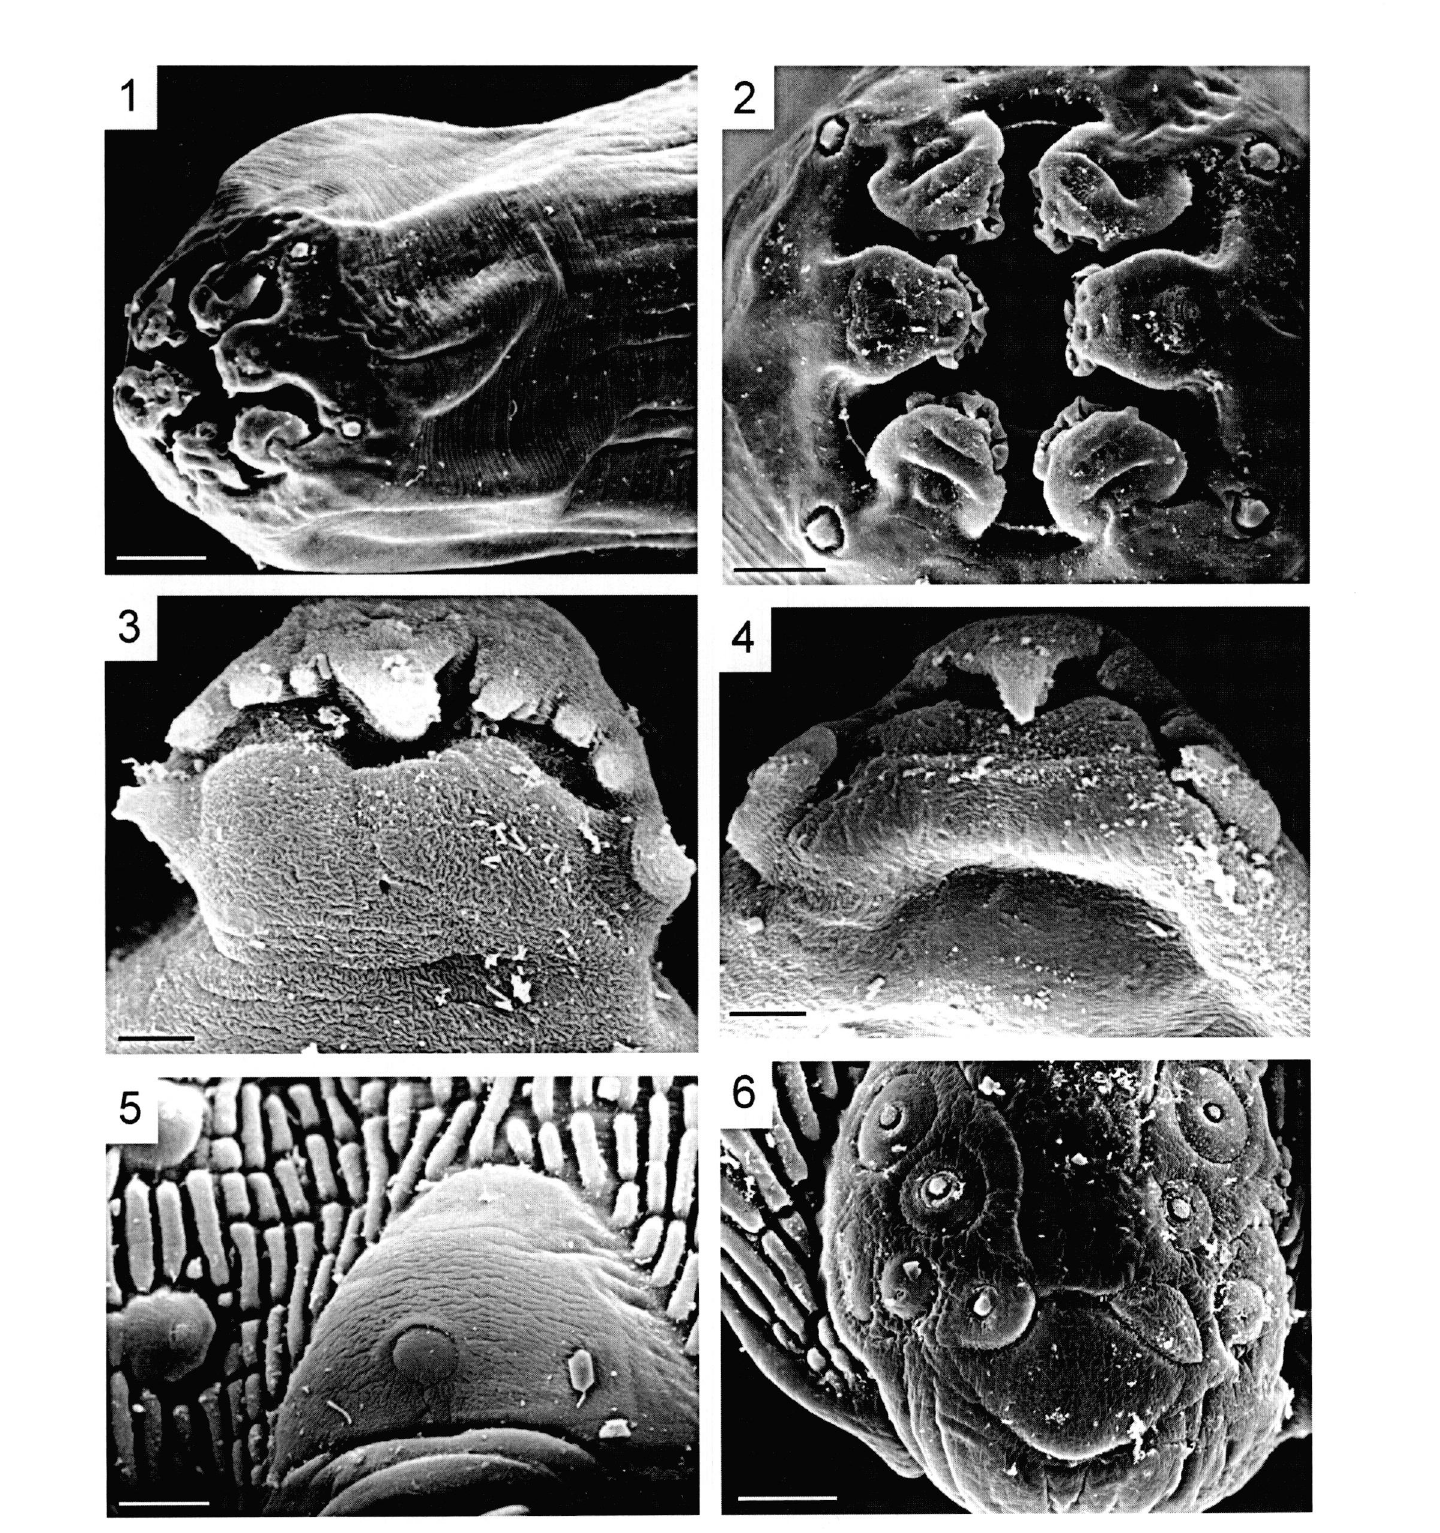
Figs 1-6. - Male of Mastophorus muris (Gmelin) from Graomys griseoflavus (Waterhouse). 1-2. anterior extremity: 1, lateral view; 2, apical view. 3-4, detail of pseudolabial teeth, showing symmetrical arrangement 1-3-1-3-1: 3, lateral lobe; 4, submedian lobe. 5-6, detail of caudal papillae, ventral view: 5, unpaired precloacal papilla; 6, distal sessile papillae. Scale bars: 1, 50 µn; 2, 5, 25 µm; 3-4, 5 µm; 6, 20